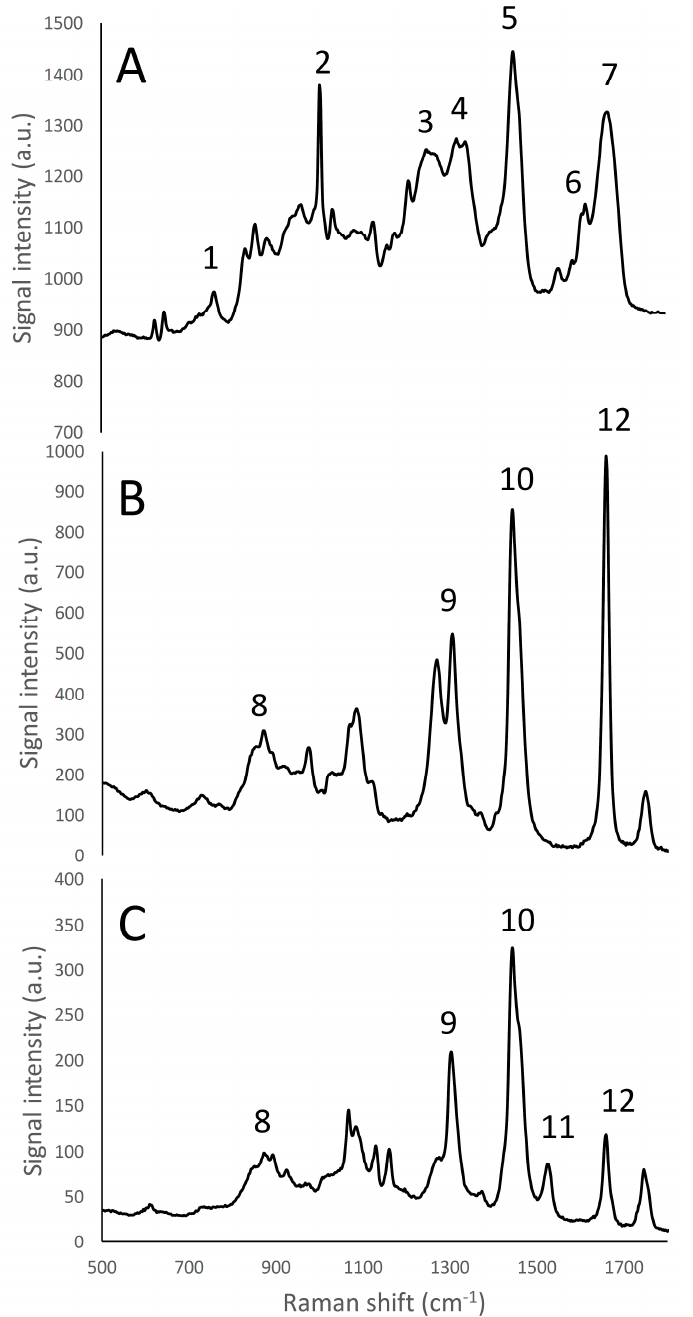
Figure 2. Raman fingerprint region (500–1800 cm − 1 ) of micellar casein isolate ( A ), rapeseed oil ( B ), and butter ( C ). Panel A: (1) tryptophan indole ring (750–760 cm − 1 ); (2) phenylalanine benzene ring breathing (1000–1005 cm − 1 ); (3) amide III β -sheet structure (1270 cm − 1 ); (4) amide III α -helices structure (1320–1340 cm − 1 ) (5) CH 2 bending peak (1450 cm − 1 ); (6) tyrosine (1614 cm − 1 ); (7) amide I (1650–1670 cm − 1 ). Panels B, C: (8) phospholipids headgroup (870 cm − 1 ); (9) CH 2 twisting of phospholipids (1300–1310 cm − 1 ); (10) CH 2 scissoring of sterols (1442 cm − 1 ); (11) Carotenoids stretching band (1525 cm − 1 ); (12) C = C cis stretching of phospholipids (1655 cm − 1